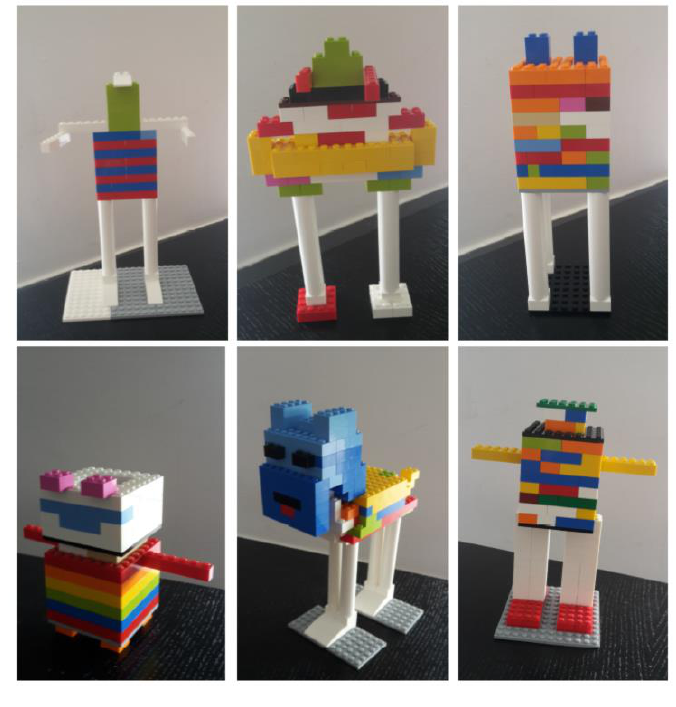
Fig. 1. Built Lego